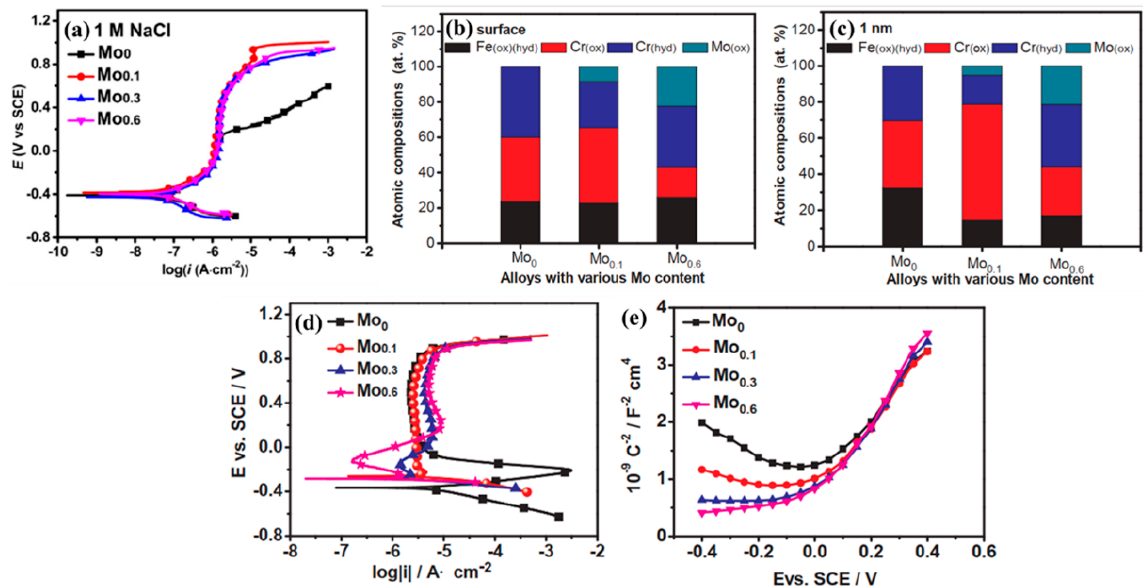
Figure 4. The polarization behavior and the surface chemistry for FeCoCrNiMo x ( x = 0, 0.1, 0.3, 0.6) HEAs. ( a ) Potentiodynamic polarization plots of FeCoCrNiMo x in 1 M NaCl aqueous solution; the content percentages of Fe (o x )(hyd) , Cr (ox) , Cr (hyd) and Mo (ox) within the surface layers of Mo 0 , Mo 0.1 and Mo 0.6 alloys: ( b ) the surface of the surface layers, and ( c ) the 1 nm depth of the surface layers; ( d ) potentiodynamic polarization curves and ( e ) Motto–Schottky plots after polarization for 4 h at 0.4 V SCE of FeCoCrNiMo x in 0.5 M H 2 SO 4 [38,41].